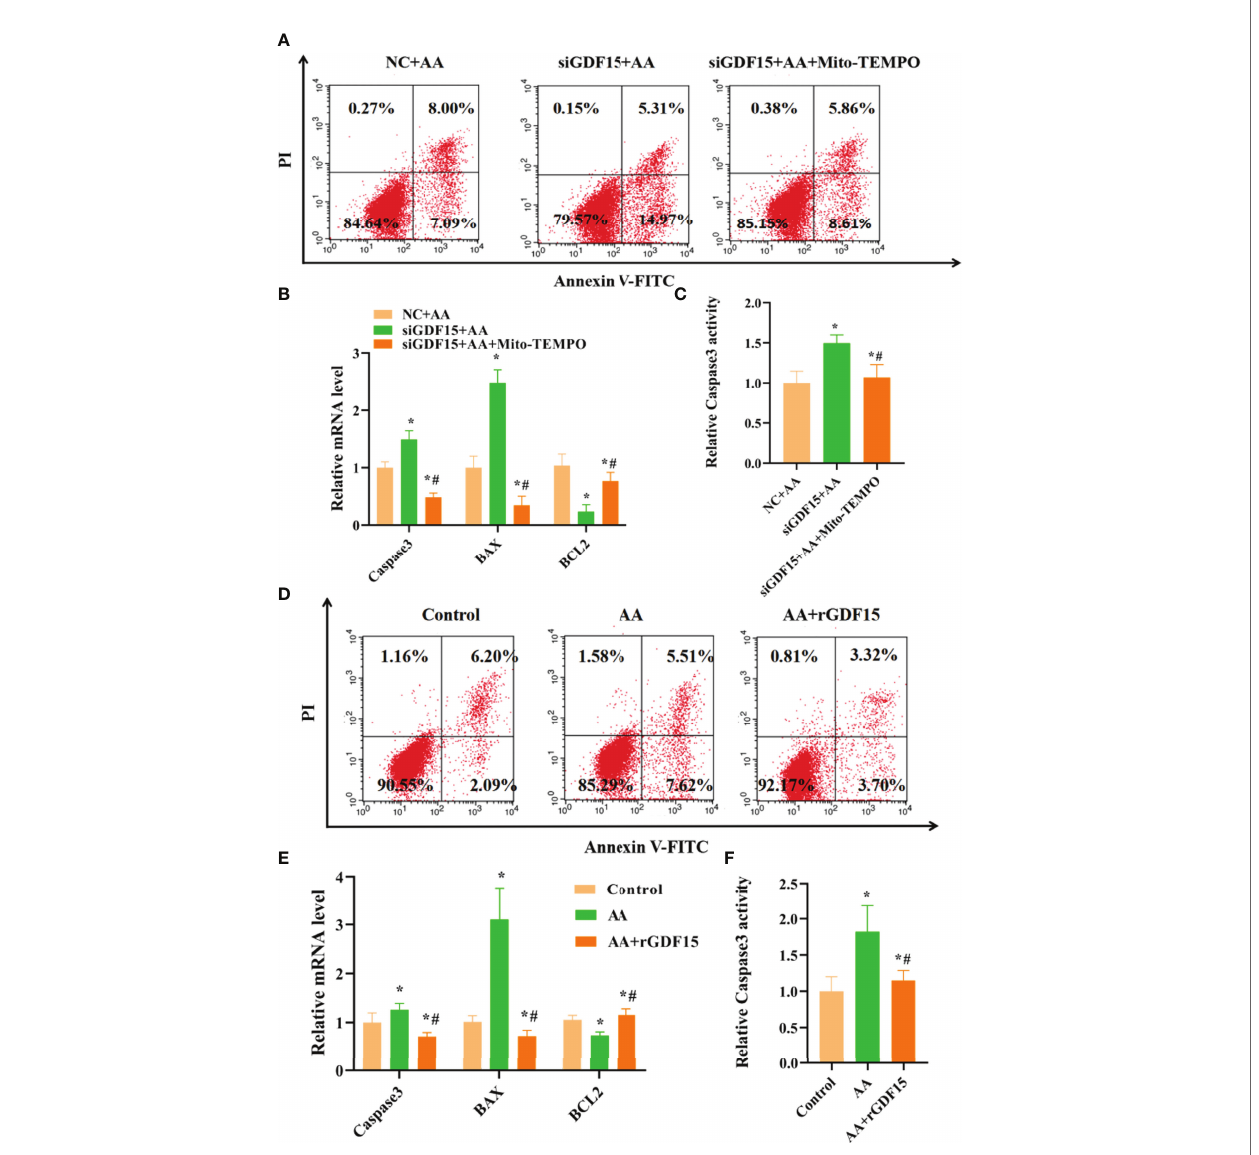
FIGURE 10 | Silencing of GDF15 increased apoptosis rate of KGN cells and supplementation with exogenous rGDF15 decreased apoptosis rate of KGNs caused by AA. (A, B) Silencing of GDF15 increased KGN cells apoptosis rate together with abnormal expression of Caspase3 、 BAX and BCL2. (C) Silencing of GDF15 promoted Caspase3 activity. (D, E) Supplementation with exogenous rGDF15 reduced KGN cells apoptosis rate together with abnormal expression of Caspase3 、 BAX and BCL2. (F) Supplementation with exogenous rGDF15 restored Caspase3 activity. Data represent mean ± standard error, *P < 0.05, * # P <